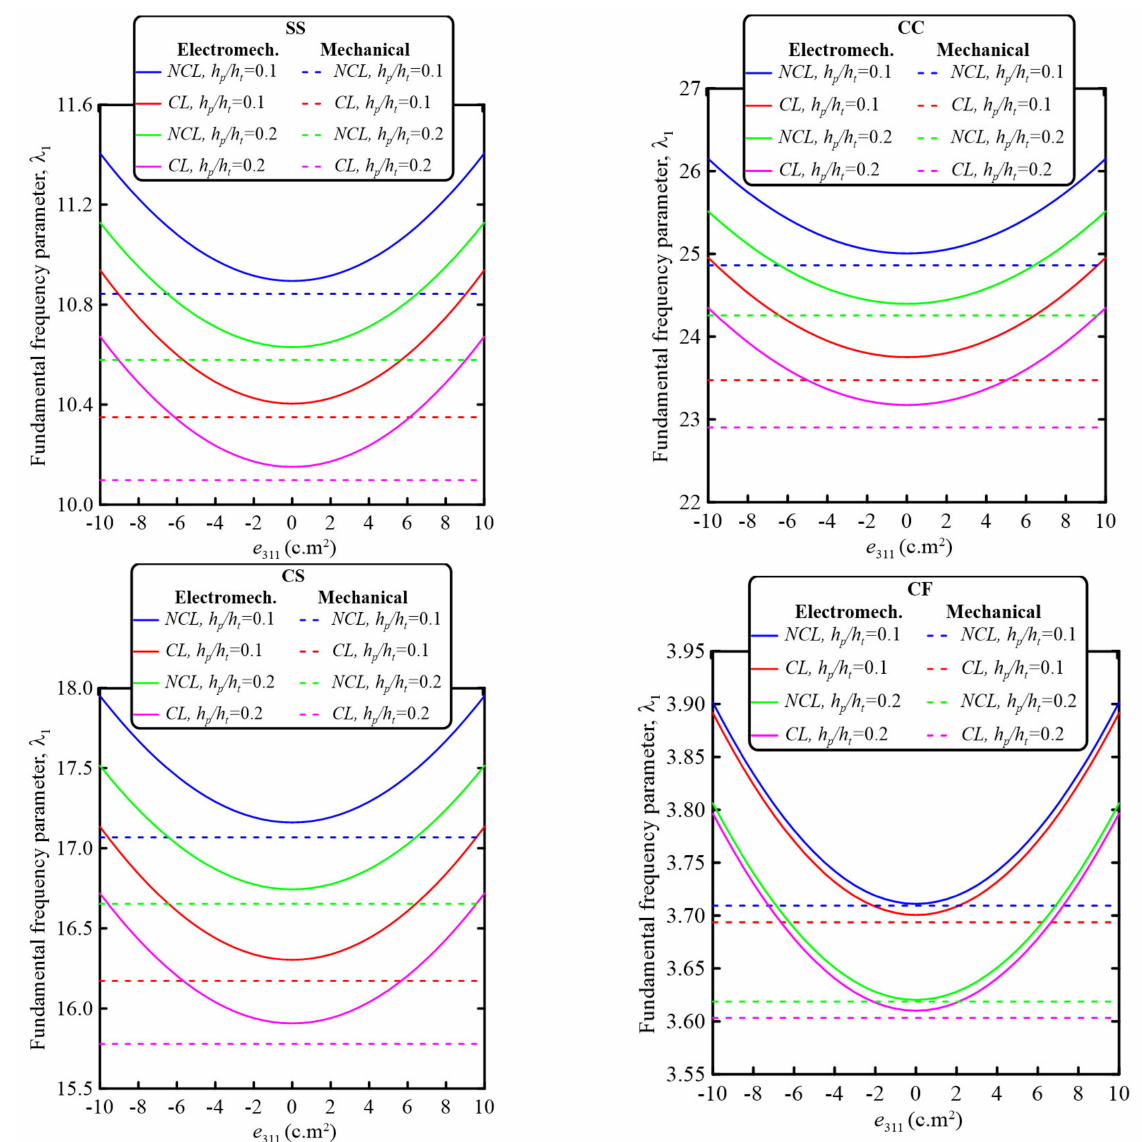
Figure 7. Variation of the fundamental frequency parameter λ 1 with the piezoelectric coefficient e 311 for nonclassical and classical electromechanical and mechanical analyses of piezoelectric sandwich nanobeams at different ratios of the piezoelectric layer thickness to the total beam thickness h p / h t for different beam boundary conditions at α = 0.5 and beam aspect ratio L / h t = 20 (N = 4, e 0 a = 0.5 nm, l = 5 nm, µ 3111 = 5 × 10 − 8 C/m, a 33 = 7.124 × 10 − 9 C/m 2